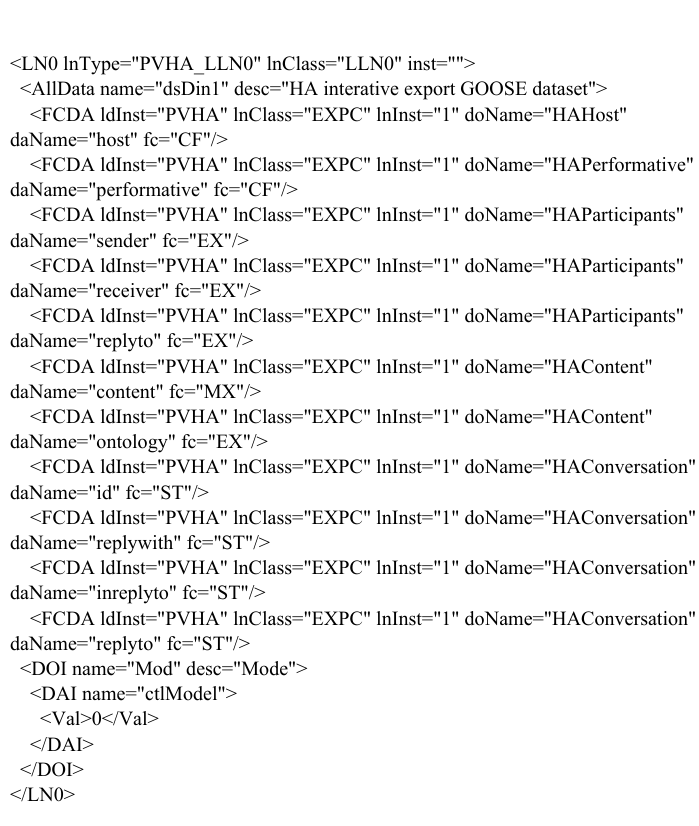
Figure A3. Substation configuration language description of LLN0 in PVHA.